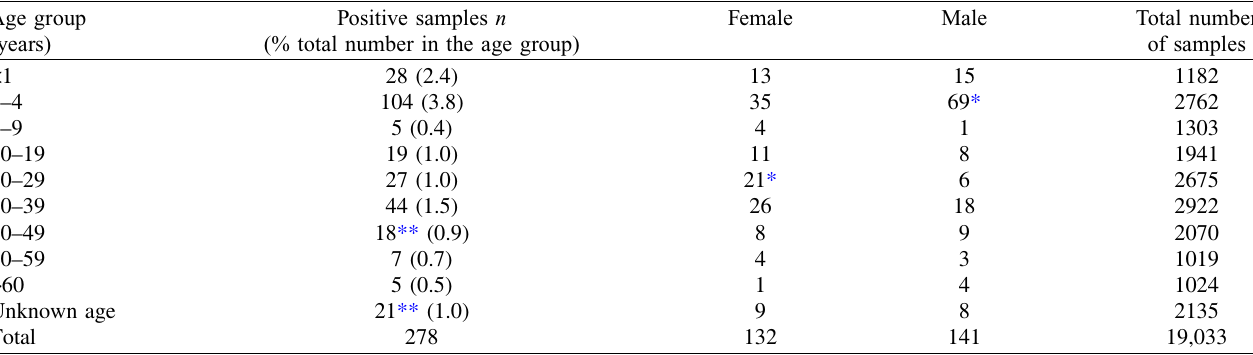
Table 1. Age and sex distribution of cryptosporidiosis from 278 cases ( n = 19,033) reported at the University Teaching Hospital, Lusaka, Zambia from January 2014 to May 2019.